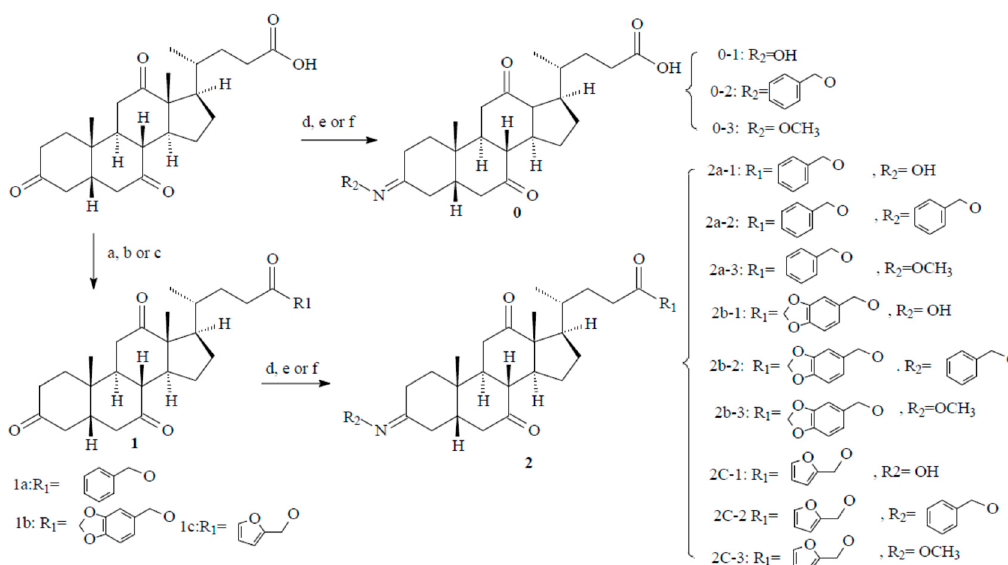
Scheme 1. Synthetic routes of target compounds. Reagents and conditions: (a) benzyl alcohol, DMAP, DCC / CH 2 Cl 2 , 0.5 h, 0 ◦ C; overnight, rt; (b) piperonyl alcohol, DMAP, DCC / CH 2 Cl 2 , 0.5 h, 0 ◦ C; overnight,